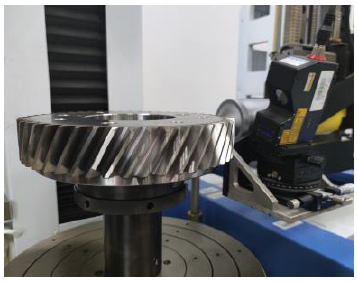
Figure 8. Point clouds extracted after multi − section scanning. 6. Discussion Considering the complete point clouds of the right tooth surface of the first tooth shown in Figure 8 as an example, according to Formula (5), the 3D normal deviation of the tooth surface is illustrated in Figure 9. Figure 9a shows the normal deviation distri- bution, especially the shape and amount of tooth surface modification. Figure 9b illus- trates the position of the maximum point and change trend and the rate of normal devi- ation.